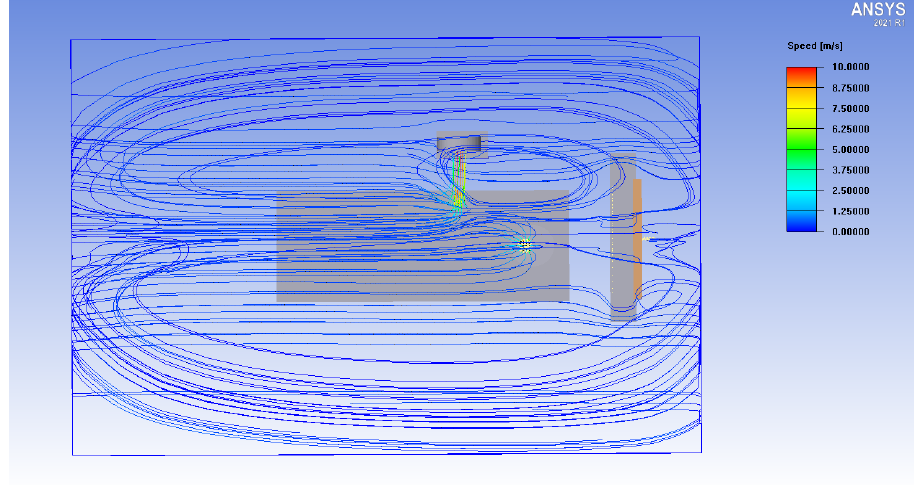
14 of 21 Figure 21. Air purifier top-view simulation in the consulting room at a high rotation speed -2. Case 2: An air purifier was installed in the hospital ward. It was designed for patients